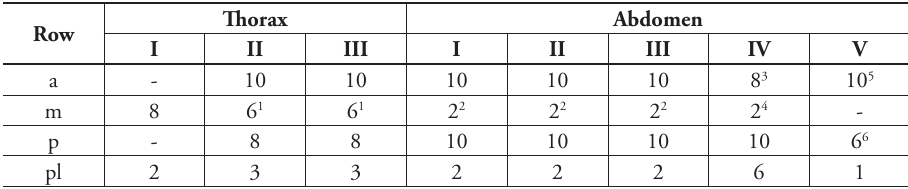
Table 2. Dorsal Chaetotaxy of Prabhergia imadatei (revised). Thorax Row